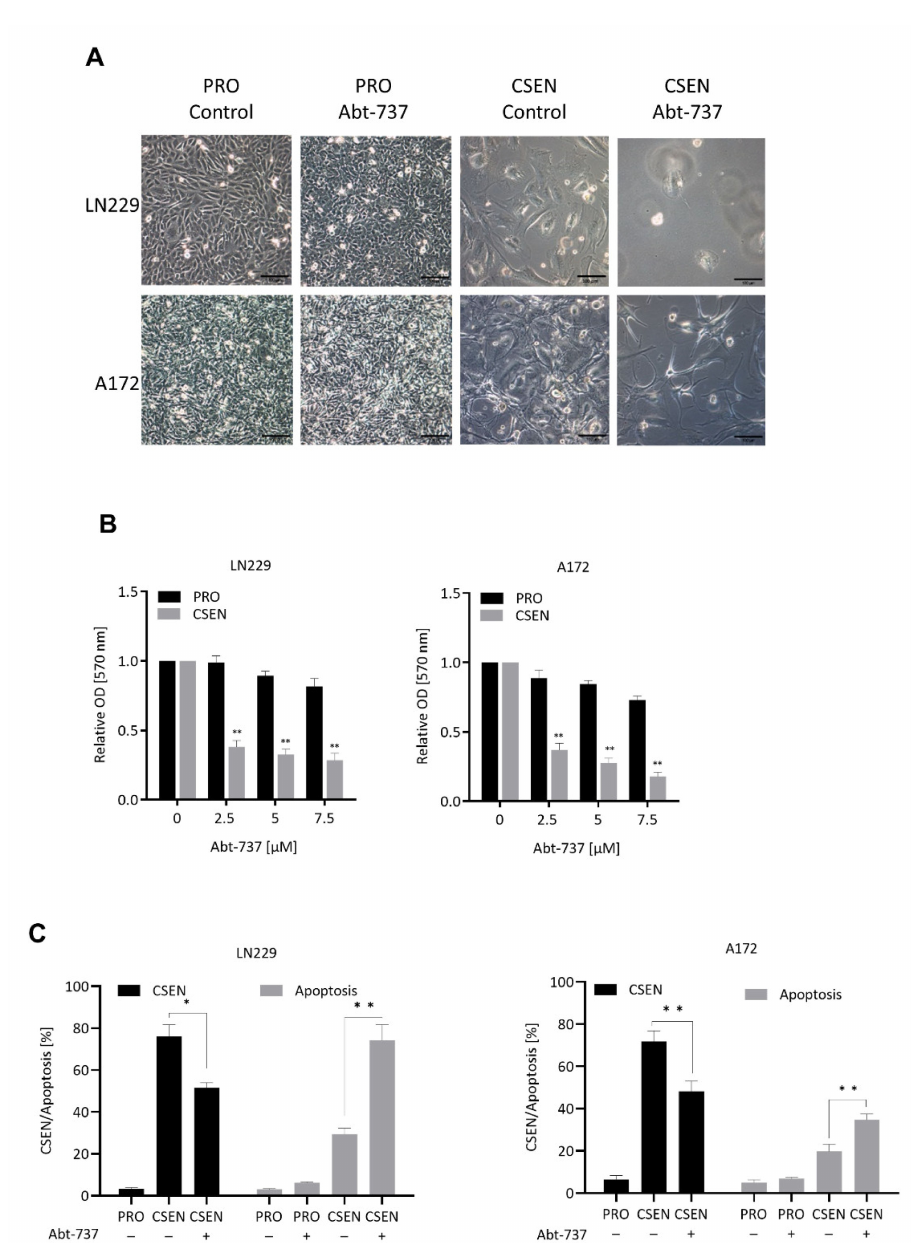
Figure 2. Effect of ABT-737 on senescent cells. ( A ) Representative images of proliferating (PRO) and senescent (CSEN) LN229 and A172 cells without (control) and with 2.5 µ M ABT-737 treatment. ( B ) Treatment of senescent LN229 and A172 cells with increasing concentrations of ABT-737 leads to a significant decrease in cell viability, as shown by MTT assay. ( C ) Decrease in senescence and increase in apoptosis shown by flow cytometry when senescent LN229 and A172 cells were treated with a non-toxic concentration (2.5 µ M) of Abt-737. Data in ( B , C ) represent the mean of >3 independent experiments ± SEM. * p < 0.05, ** p <